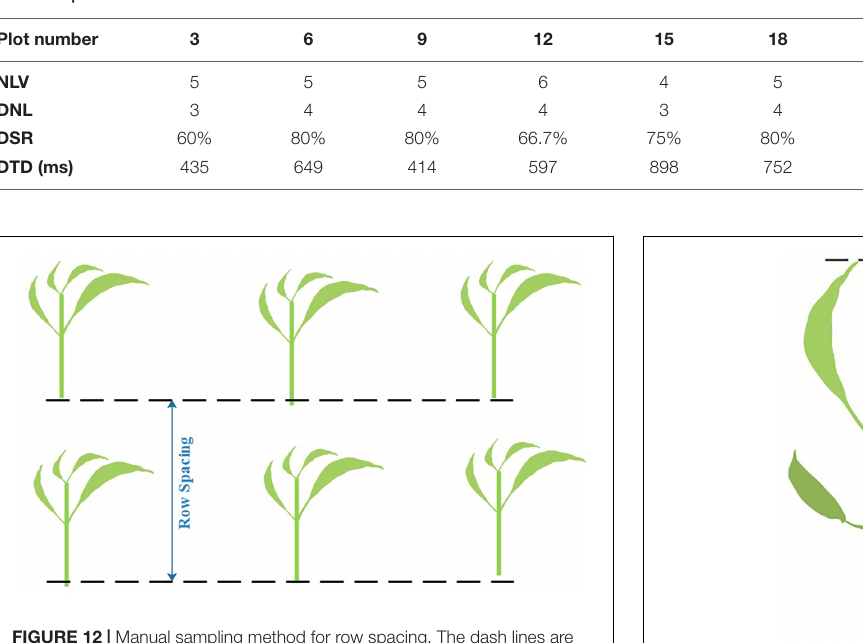
TABLE 3 | Landmark detection results for Parcel-2.